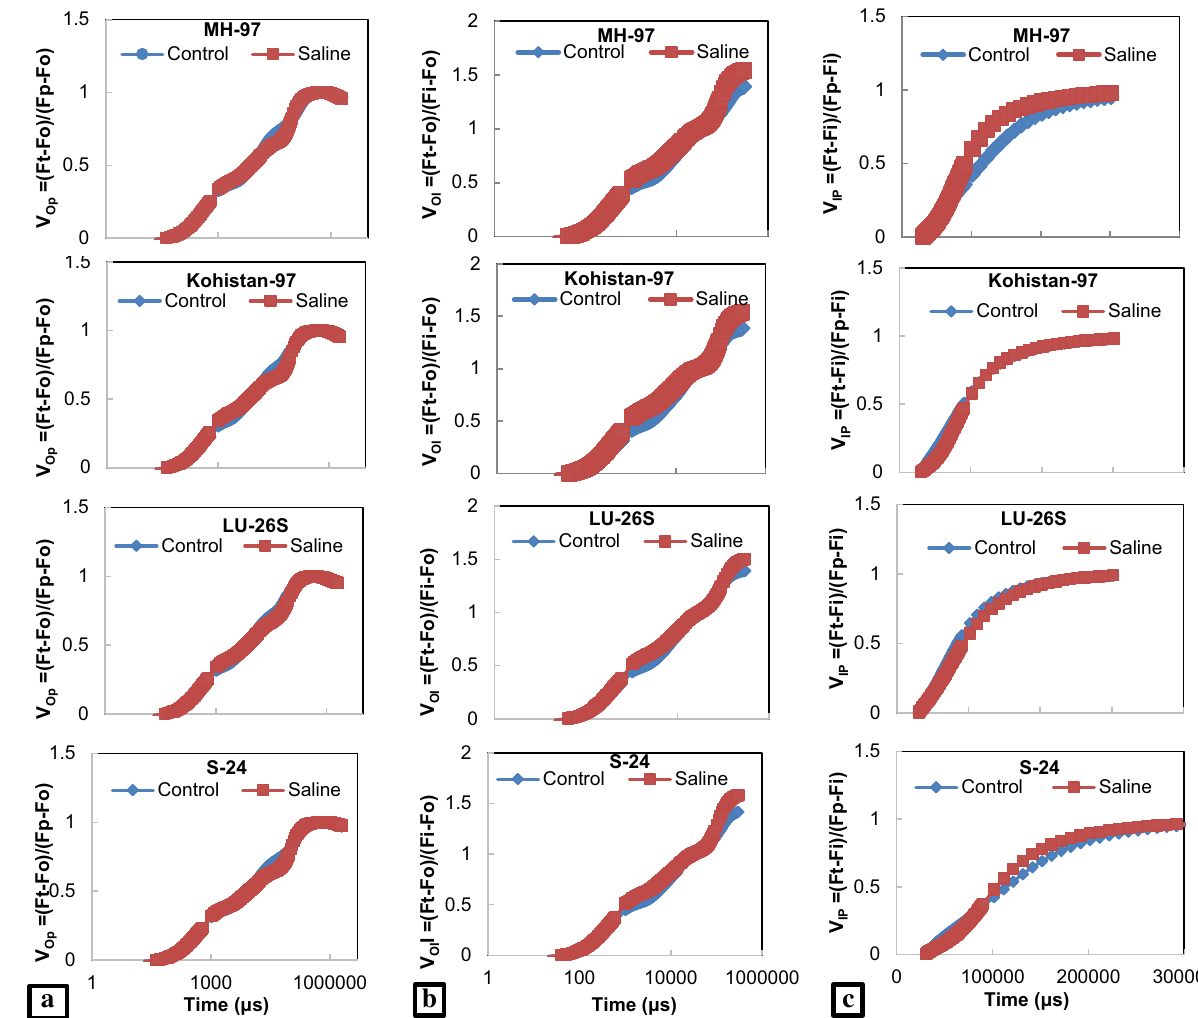
b c Figure 7. OJIP chlorophyll a fluorescence transients double normalized between ( a ) Fo and Fm (V OP ) ( b ) Fo and Fi (V OI ) and ( C ) Fi and Fp (V IP ) of four wheat cultivars subjected to 0 or 150 mM NaCl stress at vegetative